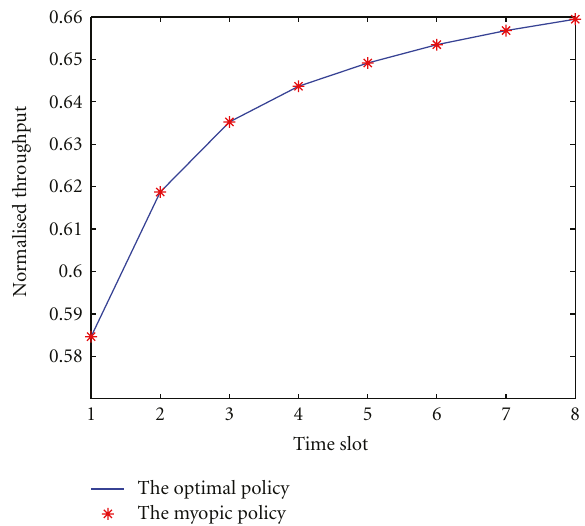
Figure 6: The performance of the myopic policy with sensor errors (Prob. of false alarm = 0 . 2, Prob. of miss detection = 0 . 3, N = 3, L = 2, p (1) 01 = [0 . 05 0 . 05 0 . 05], p (2) 01 = [0 . 3 0 . 3 0 . 3], p (1) 11 = [0 . 95 0 . 95 0 . 95], and p (2) 11 = [0 . 65 0 . 65 0 .